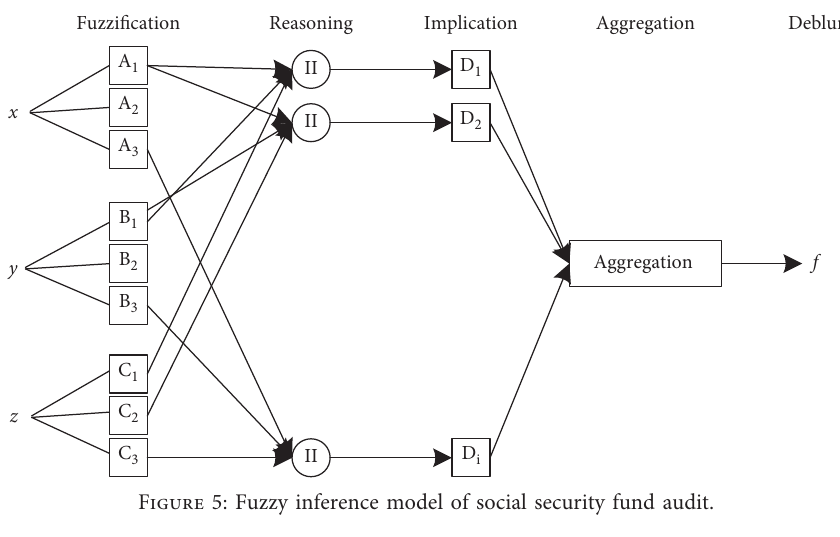
Figure 5: Fuzzy inference model of social security fund